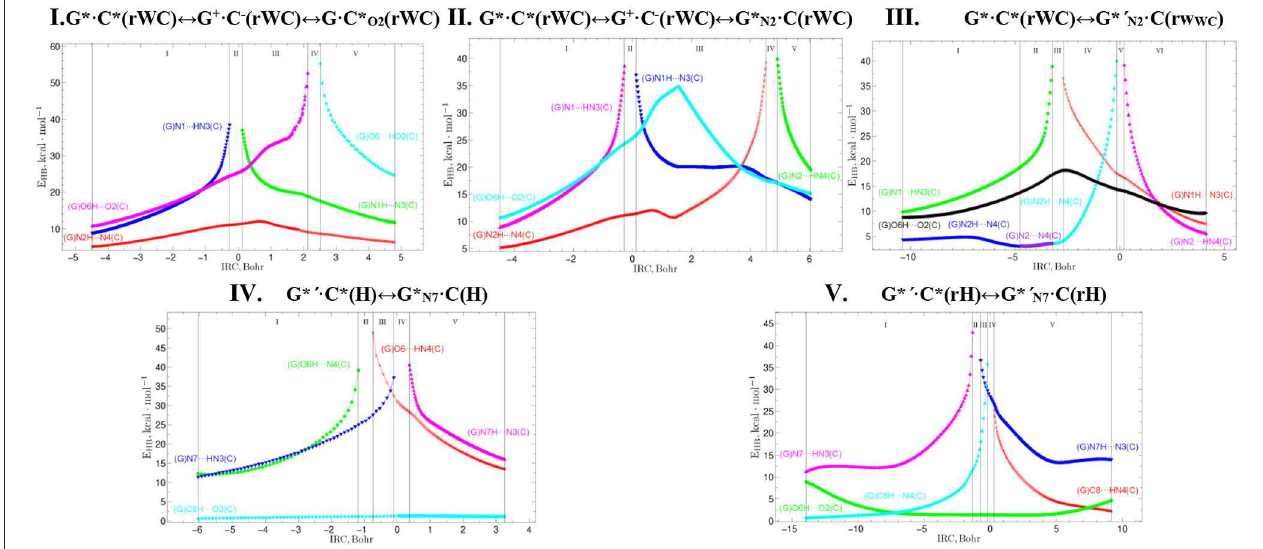
FIGURE 12 | Profiles of the energy of the intermolecular H-bonds E HB estimated by the EML formula at the (3, tautomerisations via the SPT or DPT obtained at the B3LYP/6-311